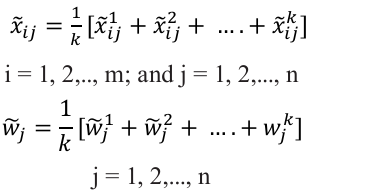
Selection of respondents. A total of 10 respondents